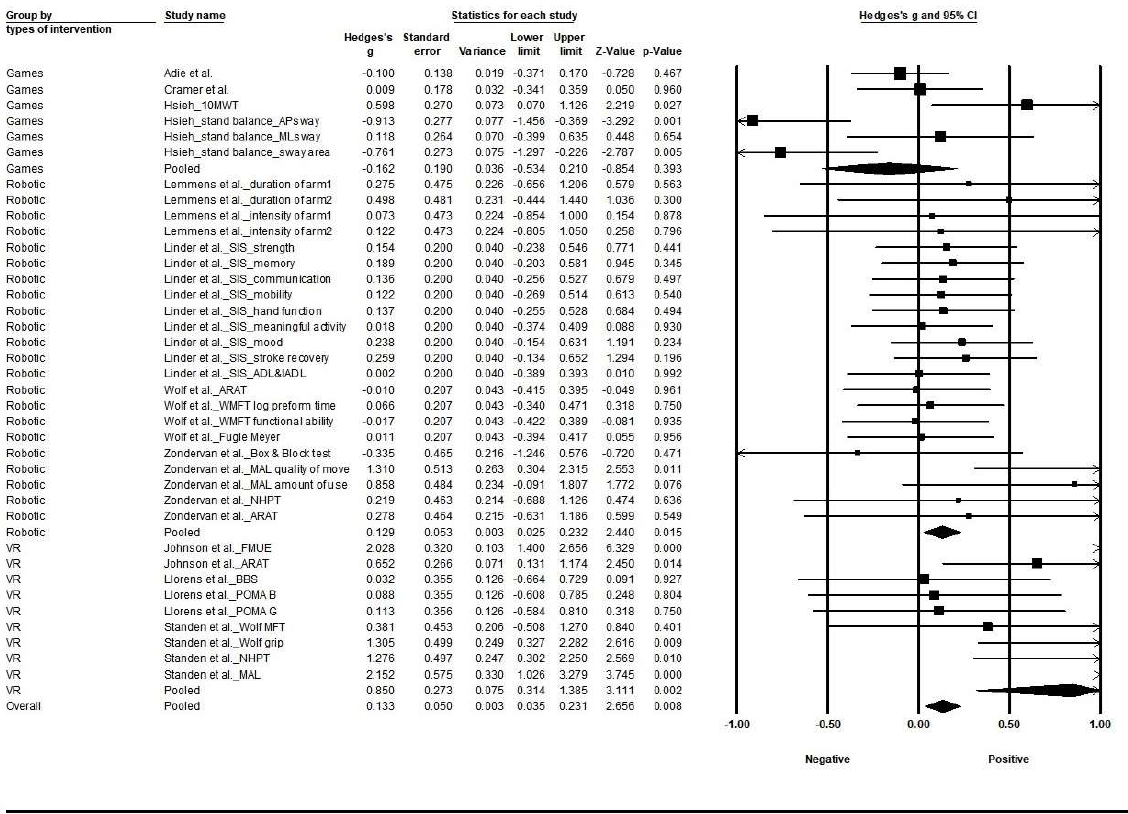
Figure 3. Forest plot among types of intervention. Abbreviations: 10 MWT, 10-Meter Walking Test; AP, anterior–posterior; ML, medial–lateral; SIS, Stroke Impact Scale; (I)ADL, (Instrumental) Activity in Daily Life; ARAT, Action Research Arm Test; BBS, Brunel Balance Assessment; POMA B, Performance-Oriented Mobility Assessment-Balance; POMA G, Performance-Oriented Mobility Assessment-Gait; MFT, Motor Function Test; NHPT, Nine-Hole Peg Test; MAL, Motor Activity Log. (squares and circle show a mean of effect size, arrow presents the 95% confidential interval). Summary of Figure 3: The effect size, Hedges’s g, was −0.162 ( p = 0.393) in games [13–15], 0.129 ( p = 0.015) in robot-assisted devices [17–19,21], and 0.850 ( p = 0.002) in virtual reality [12,16,20]. That is, robot-assisted devices and VR intervention had a positive effect on physical function. VR, virtual reality.